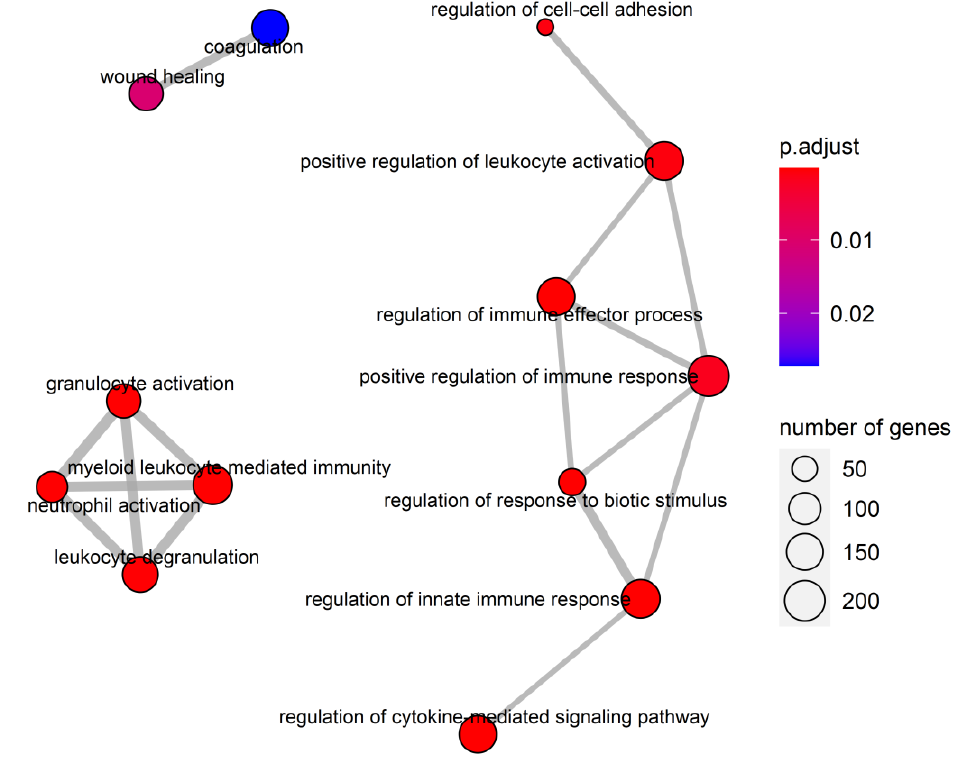
Figure 2. The enrichment map of the gene set enrichment analysis (GSEA) of Gene Ontology (GO) gene sets. The edges between the enriched GO terms indicate that the Jaccard similarity among the gene sets was larger than 0.25, in which the width represents the level of Jaccard similarity. The size of nodes shows the size of GOBP gene sets. The color of nodes indicates the level of adjusted p -values for enriched gene